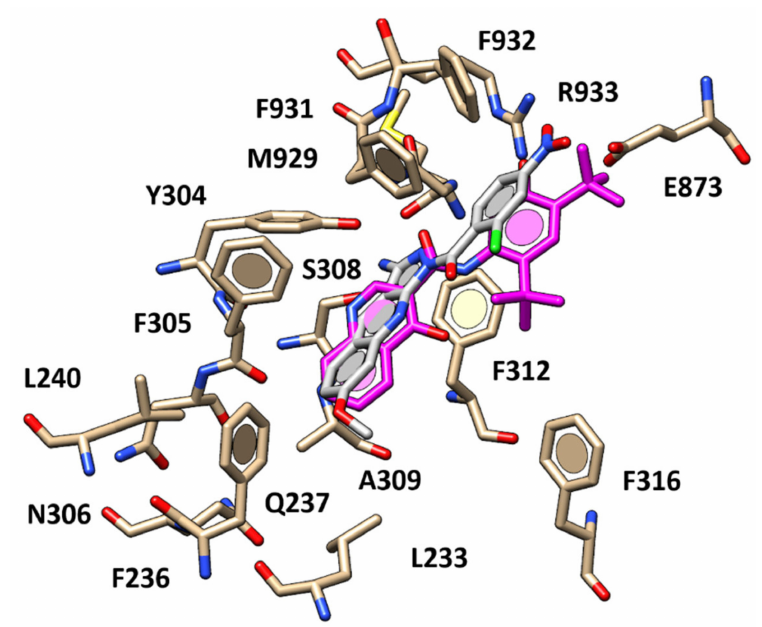
Figure 10. Docking positioning of compound 78 ( C atom; light gray) within the X-ray crystallographic structure of the human CFTR in the presence of the docked VX-770 ( C atom;